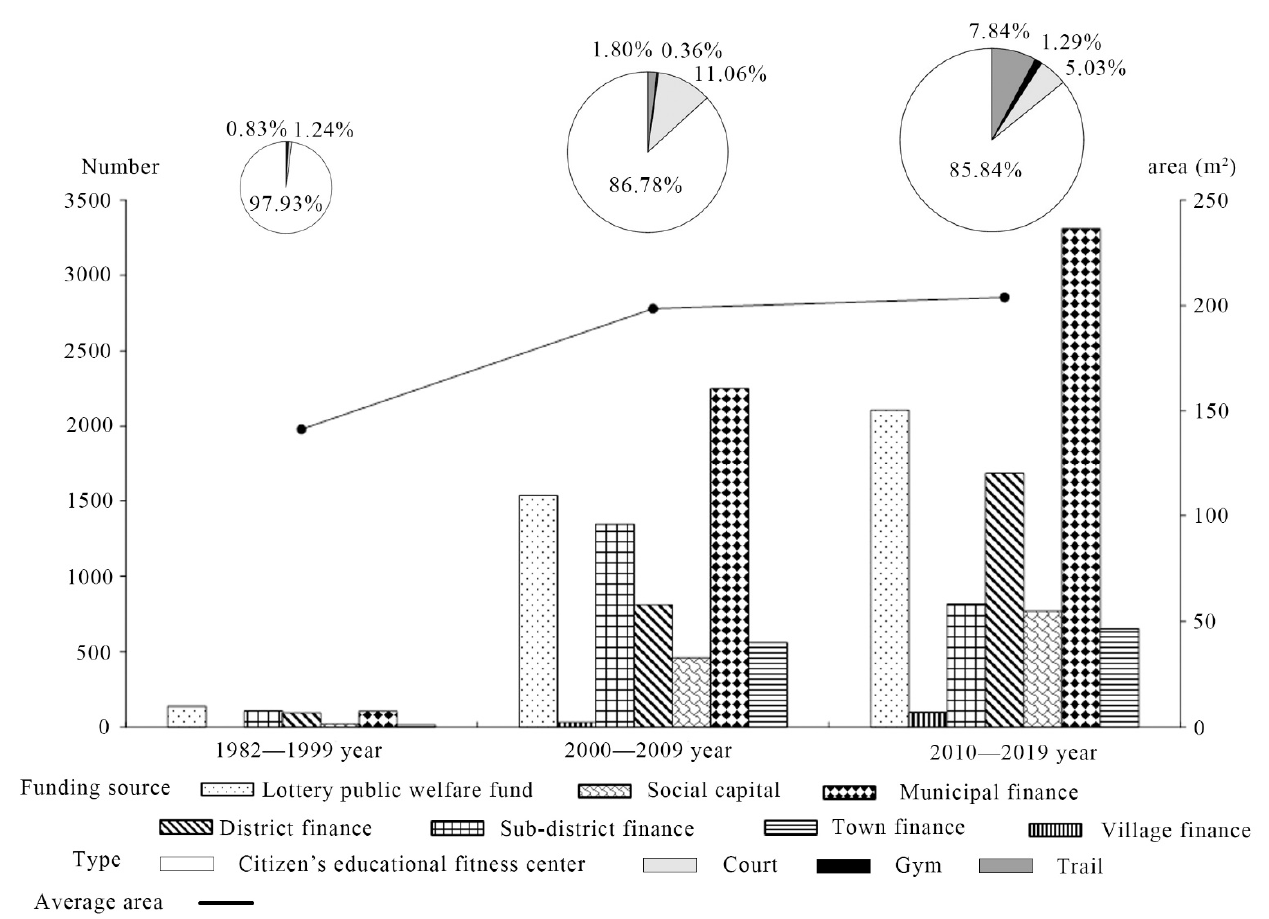
Figure 5. Evolution of the attributes of Shanghai’s community sports and fitness venues.